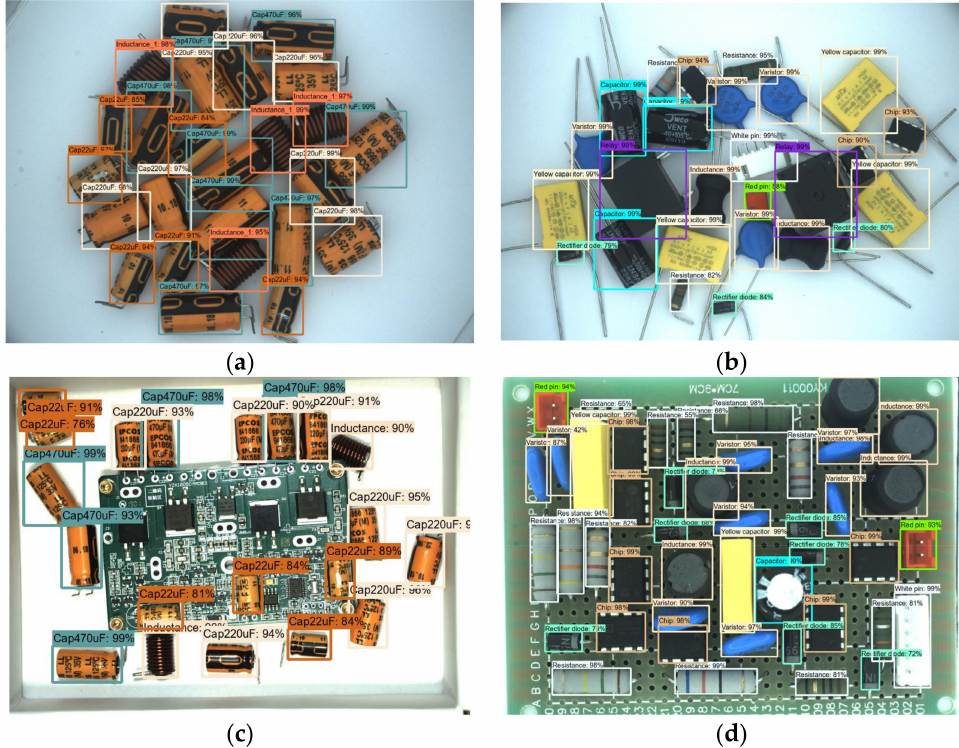
Figure 11. Detection results on multi-scene electronic component